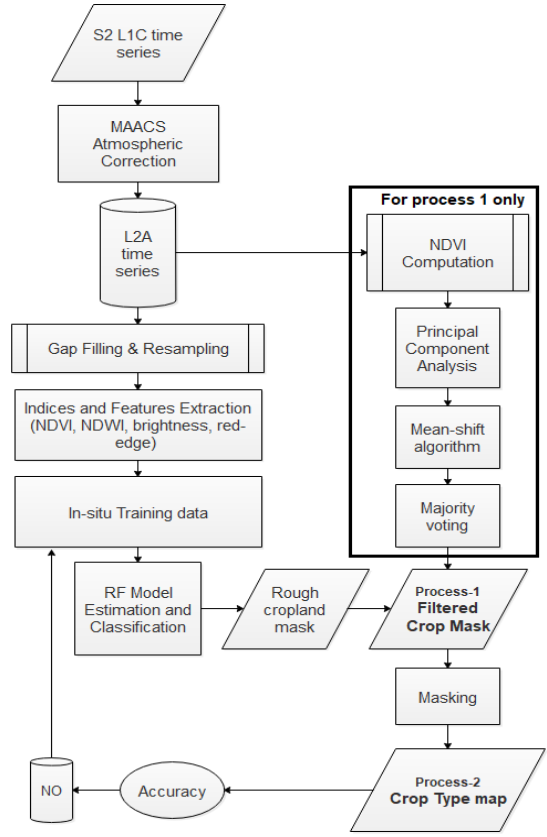
Figure 2. Methodology workflow of Sen2-Agri